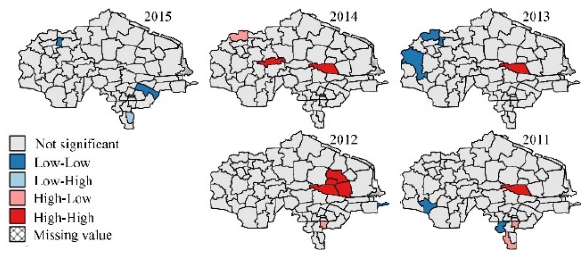
Figure 15. Univariate local Moran: the proportion of Figure 16. Univariate local Moran: the proportion of Figure 16. Univariate local Moran: the proportion of people aged over 100 in comparison with those people aged over 100 in the over-60 group. people aged over 100 in comparison with those aged aged 90–99.